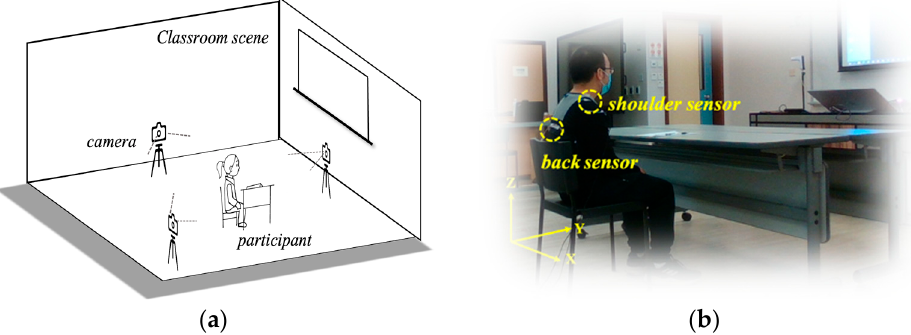
Figure 1. The acquisition system of the experiment. ( a ) The schematic diagram of the motion acqui ‐ sition system in the classroom scene; ( b ) The location of the sensors. The vision information of the participants’ motions is collected through cameras from three perspectives to assist in the classifica ‐ tion. One sensor was placed in the center of the participant’s spine and another one on the right shoulder to collect data on the participant’s